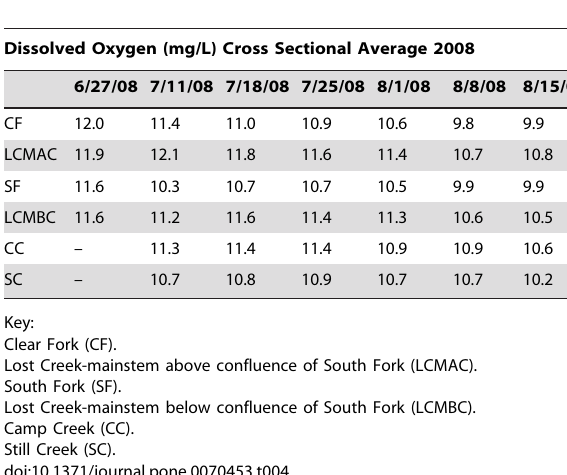
Table 4. Dissolved Oxygen 2008.